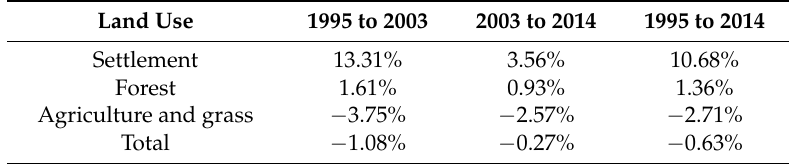
Table 6. Changes in GPP estimation per year (% year − 1 ) for each type of land use from 1995 to